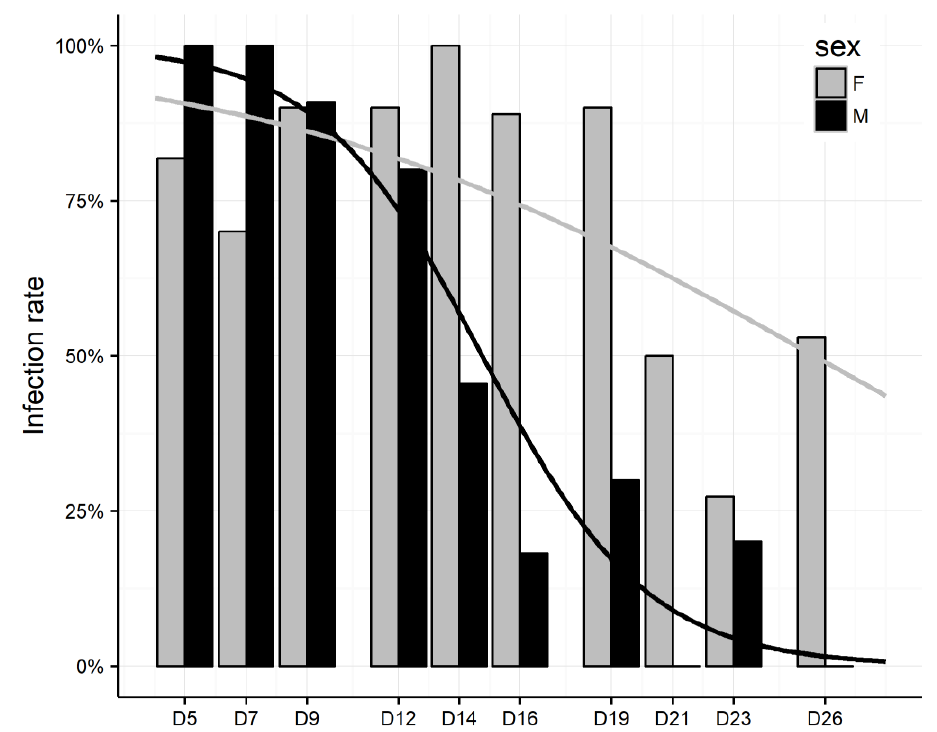
Figure 2. Infection of female and male Phlebotomus perniciosus by Massilia virus (MASV) using sugar-meal. Fitted lines for each sex are calculated from the original data according model with quasi-binomial distribution. F = female, M = male.